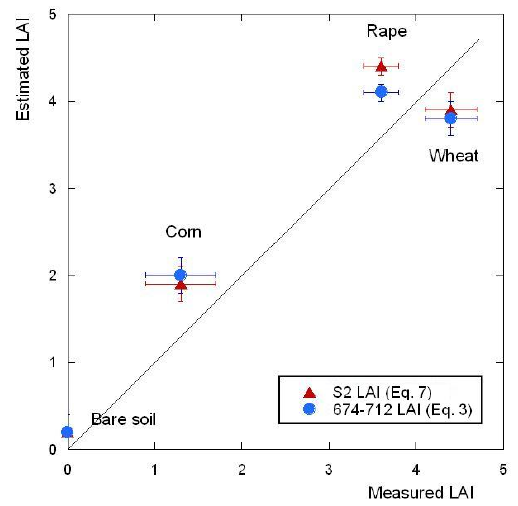
Figure 3. Scatter plot of in situ measured versus estimated green LAI values according to Equation 3 and Equation 7 from AgriSAR data with corresponding error